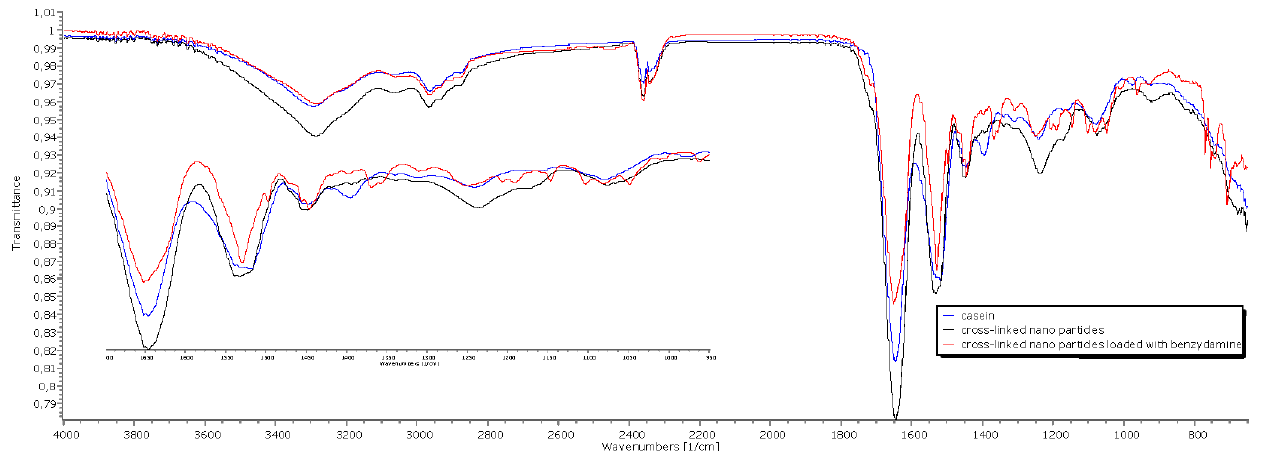
Figure 6. ATR-FTIR spectra of casein, crosslinked placebo nanoparticles and crosslinked BZ-loaded nanoparticles.